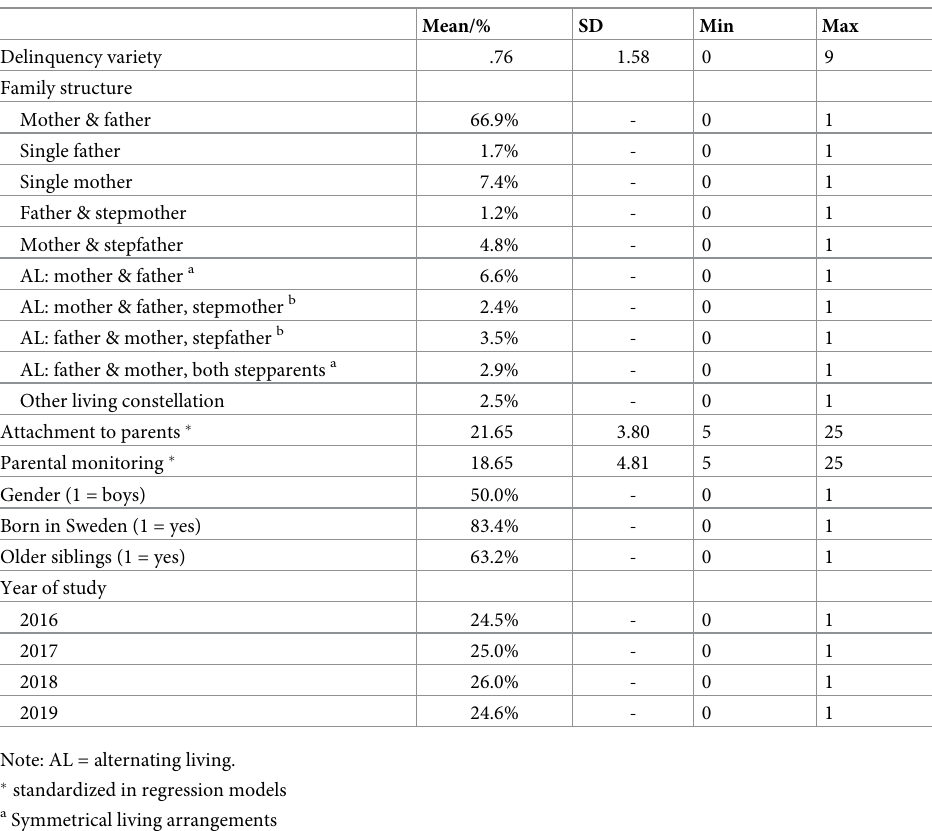
Table 1. Descriptive statistics (N = 3,838).